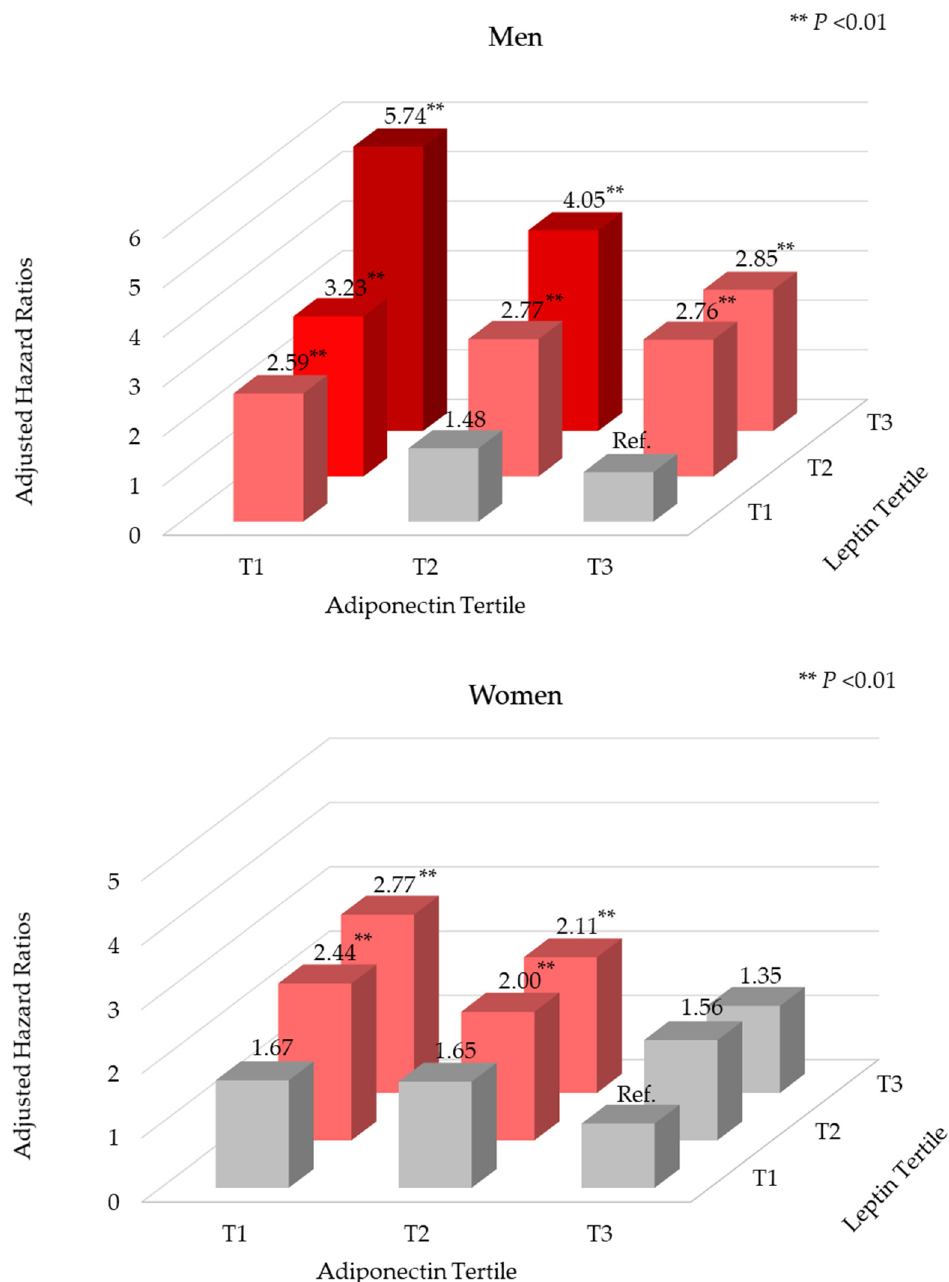
Figure 2. Association of metabolic syndrome by baseline adiponectin and leptin level strata in Korean adults aged 45–76 years 1 . 1 Model was adjusted for age (years), area of residence (Ansan or Ansung), education level ( ≤ elementary school, middle/high school, or ≥ college), smoking status (never, past, or current), alcohol consumption (g/day), regular physical activity (yes or no), BMI (kg/m 2 ), family history of diabetes (yes or no), and serum hs-CRP level (mg/L).